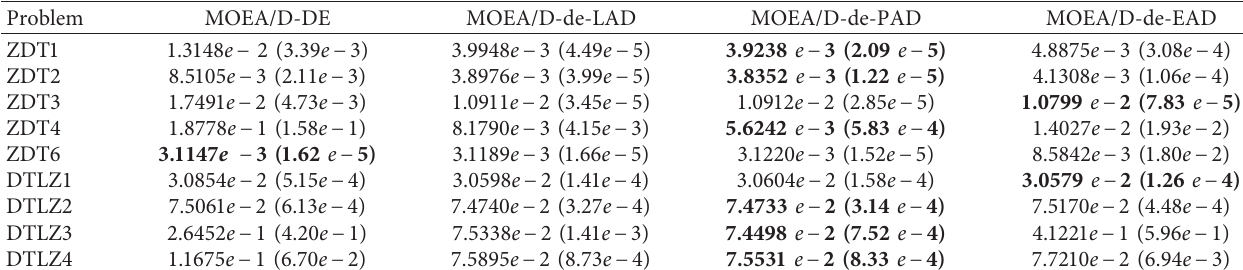
Table 2: IGD metric (mean/std)